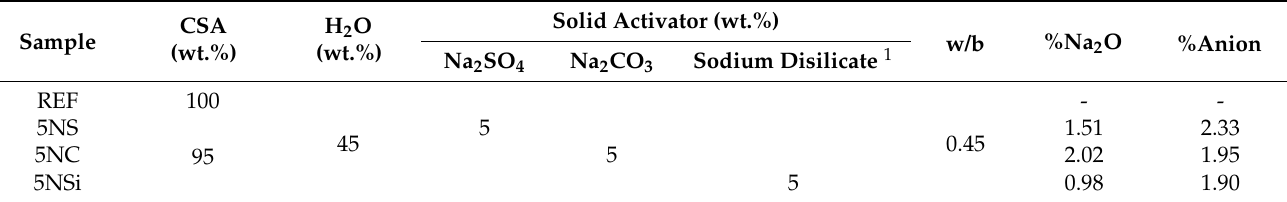
Table 4. Material nomenclature and pastes